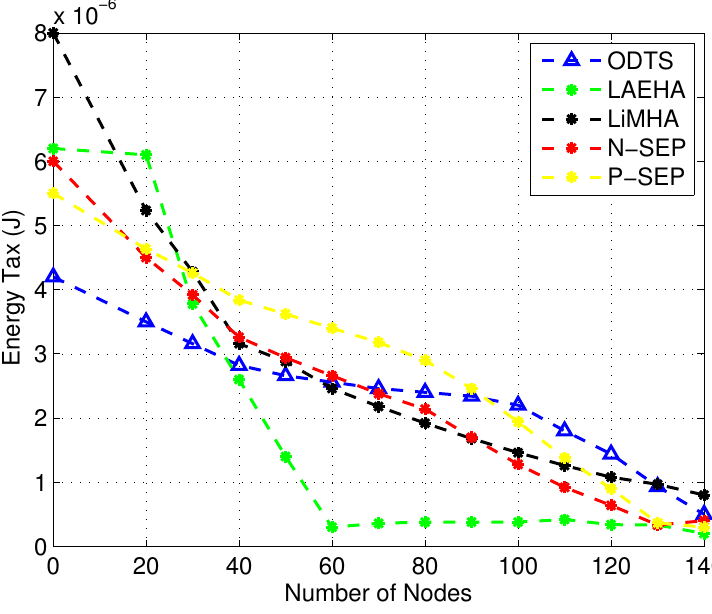
Figure 6. Energy Tax with Different Node ρ